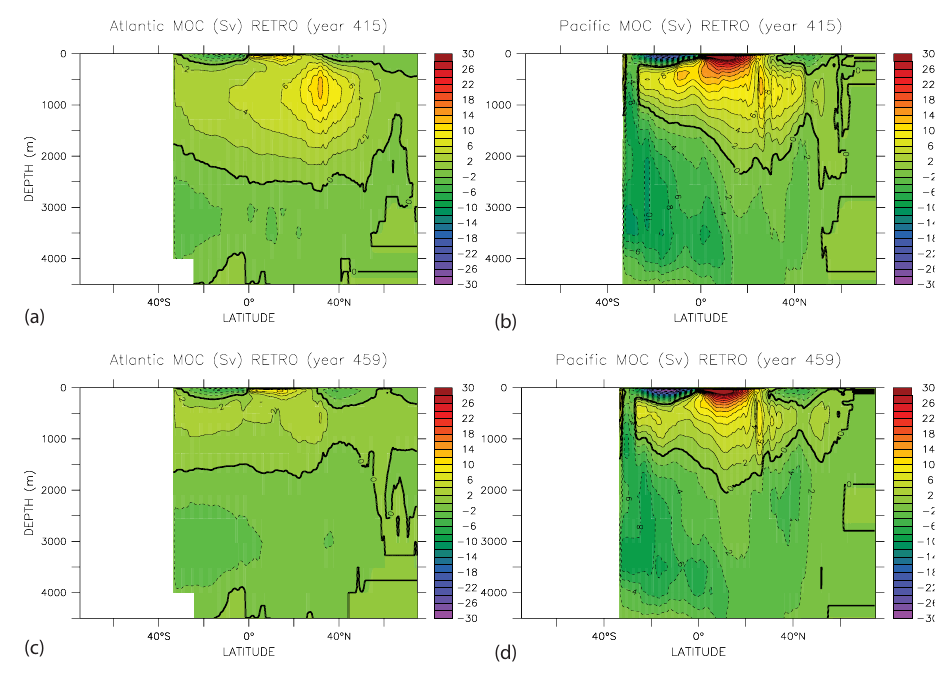
Fig. 5. Meridional overturning streamfunctions (in Sv) in the Atlantic and the Pacific. (a, b) Strong Atlantic overturning (with a maximum of 13Sv) and (c, d) weak Atlantic overturning.